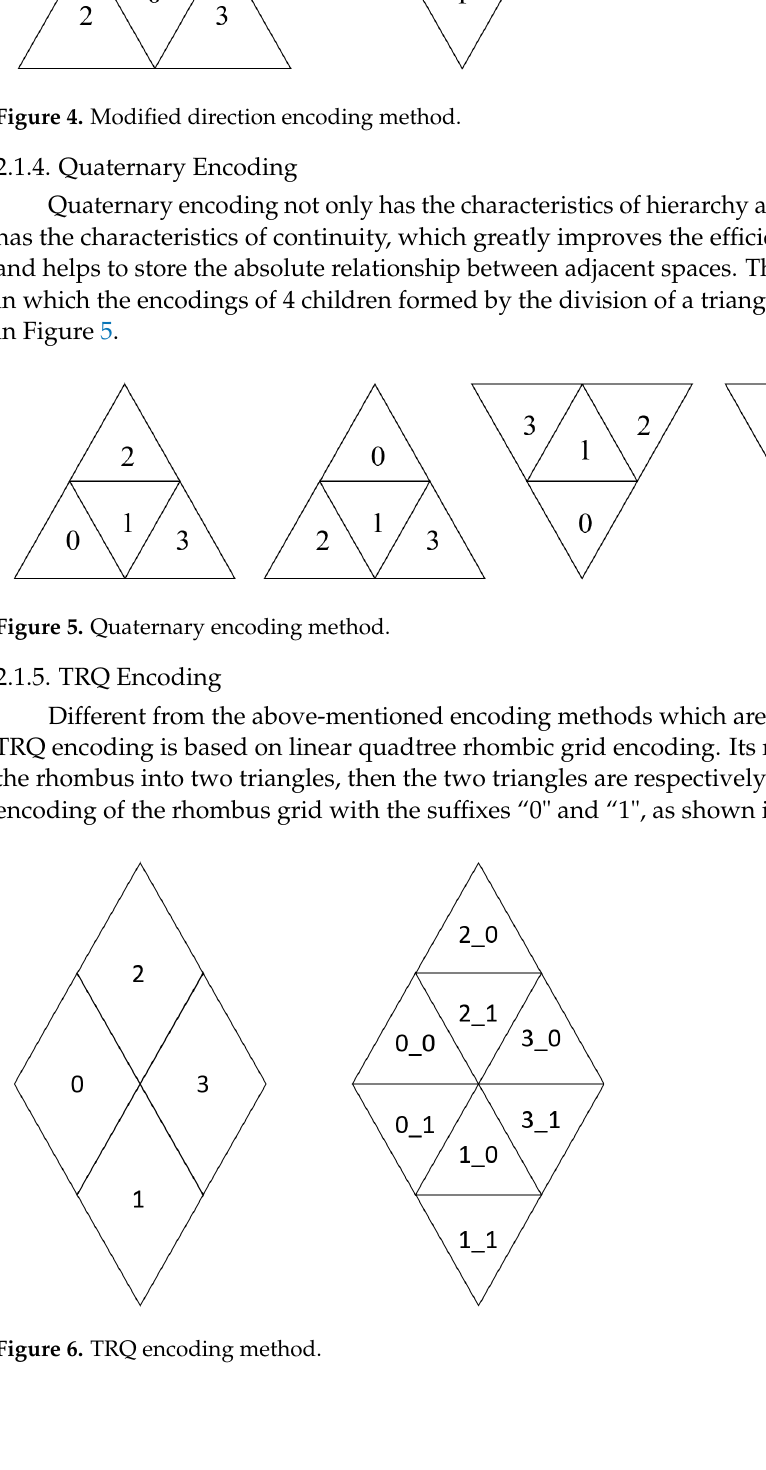
Figure 7. Arithmetic layer encoding method. 2.2. Encoding Classification 2.2.1. Hierarchical Encoding The boundaries of the parent and child cells generated by QTM dividing are com- pletely coincident. Their hierarchical relationship is simple and clear, so QTM generally uses hierarchical encoding to establish grid identification.